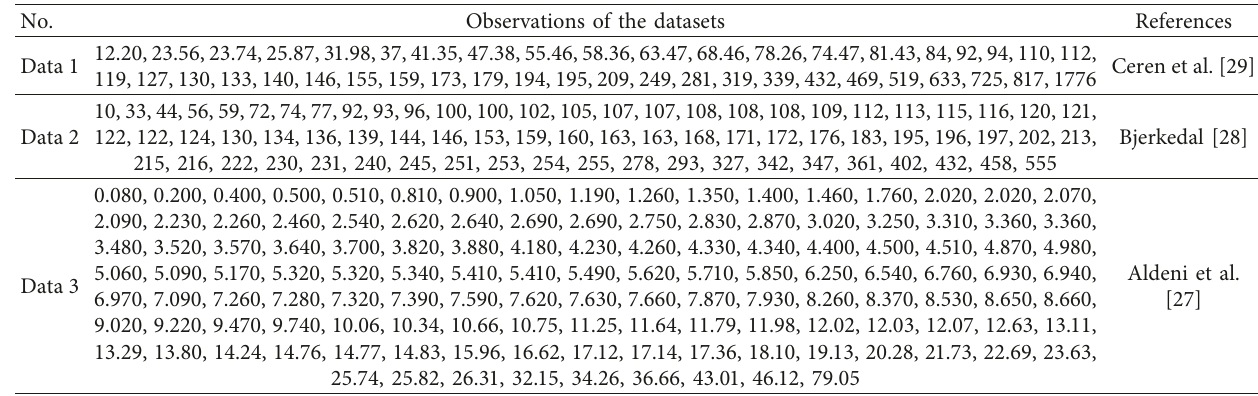
Table 3: The medical